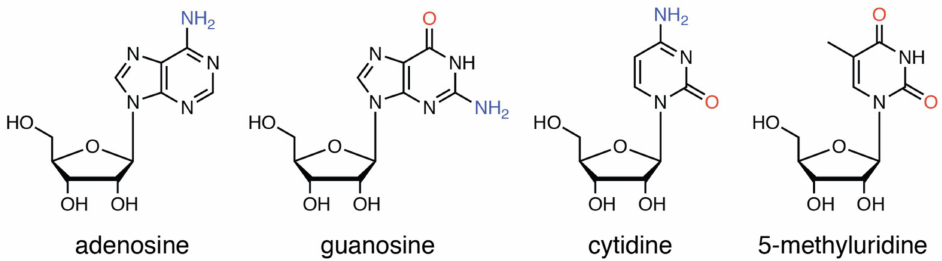
Figure 5. Chemical structures of the nucleosides employed in this study. Hydrogen-bond donors and acceptors are shown in blue and red